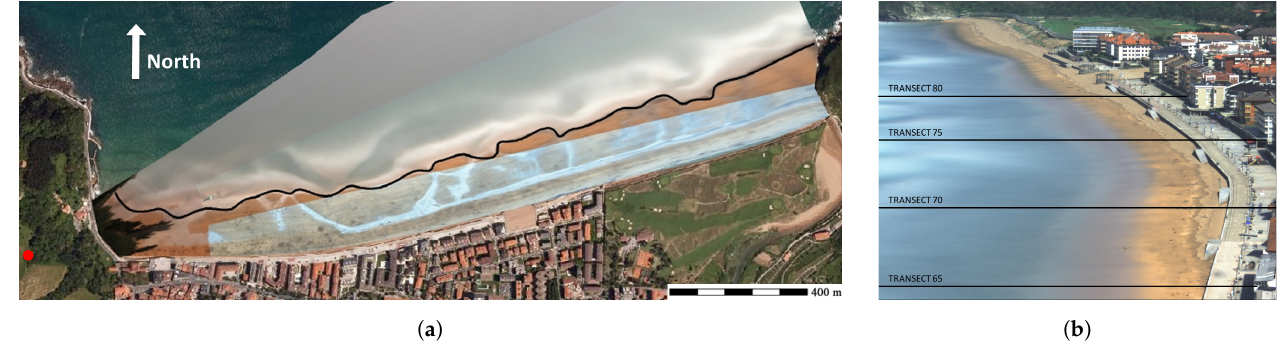
Figure 4. ( a ) Satellite view of the site of Zarautz from Google Earth, with the red point representing the location of the video monitoring station. ( b ) Positions of the transects on the site of